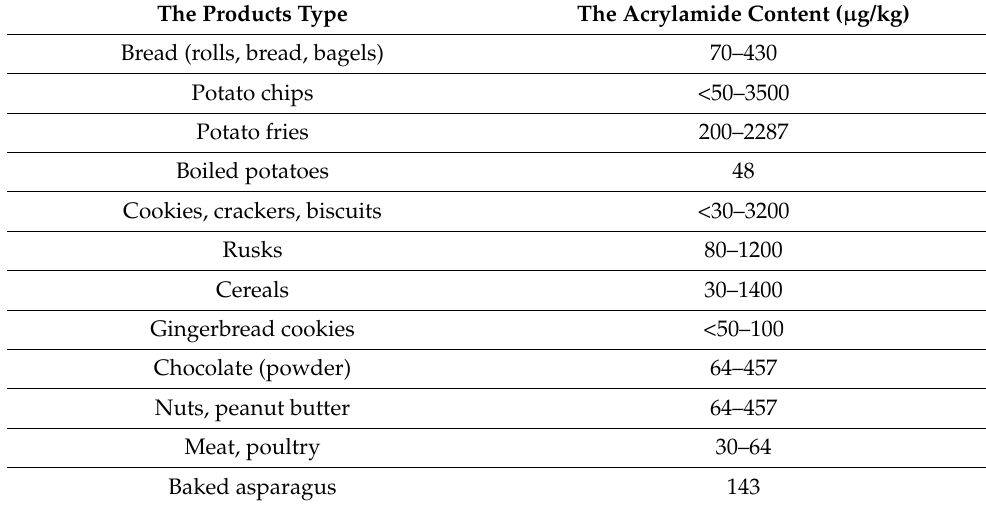
Table 1. The content of acrylamide in food